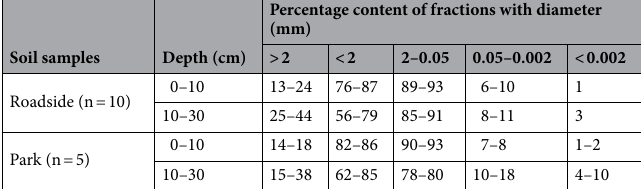
Table 1. Granulometric composition of soil samples (values are